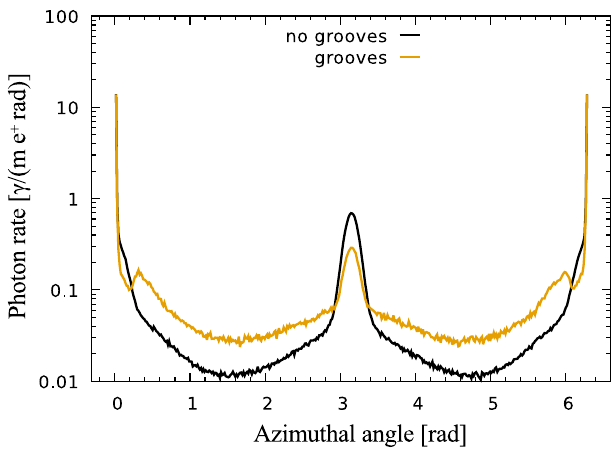
FIG. 7. Comparison of the azimuthal absorption location of the absorbed photons in the dipole regions when microgrooves are introduced in the CESR vacuum chamber geometry. The azimu- thal angle is defined to be 180° in the horizontal plane containing the beam axis on the inside of the ring. (Beam energy is 5.3 GeV.)